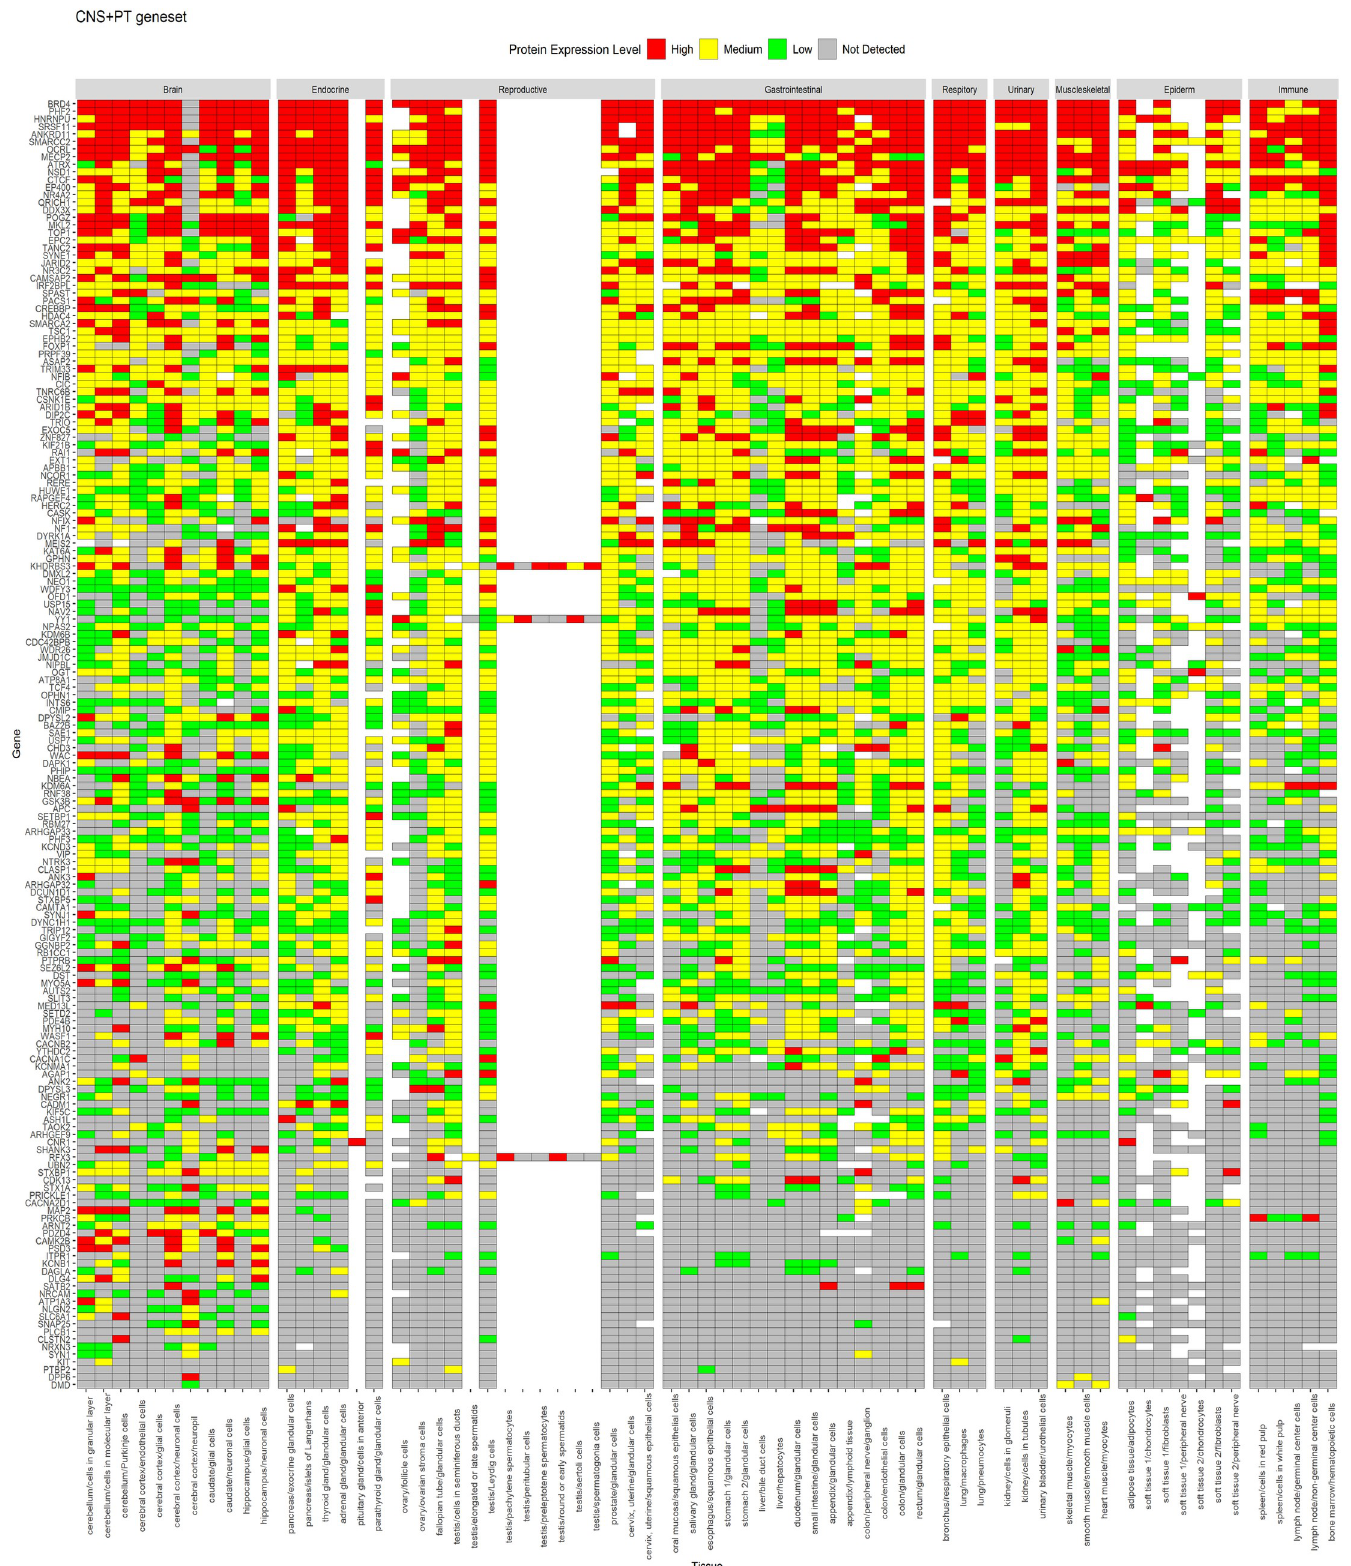
Fig 5. Protein expression of CNS+PT geneset from HPA across tissues. Genes are displayed in order of decreasing expression. https://doi.org/10.1371/journal.pone.0242773.g005 PLOS ONE | https://doi.org/10.1371/journal.pone.0242773 December18,